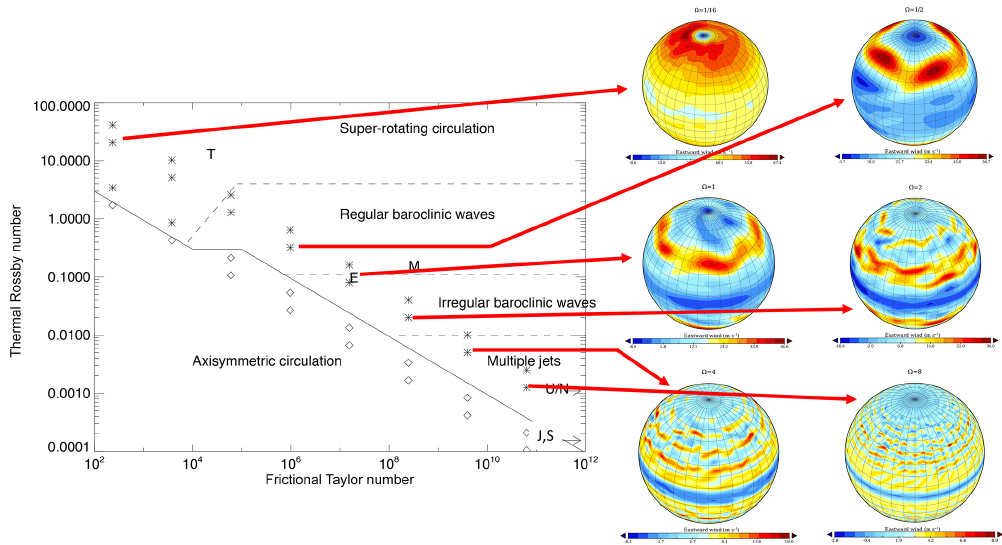
Figure 9. Regime diagram showing the various circulation regimes obtained in a simplified atmospheric general circulation model (Wang et al., 2018) with respect to characteristic dimensionless parameters ( Ro T and T F ). Stars refer to experiments in which wavy flows are observed, whereas open diamonds indicate experiments in which axisymmetric flows were found. The approximate locations in parameter space of some solar-system planets (Earth, Mars, Titan, Jupiter, Saturn, Uranus and Neptune) are labelled by their initial letters. The solid line delineates the boundary between axisymmetric circulations and circulations with wavy/turbulent flows. The dashed lines indicate the boundaries between different circulation regimes within the wavy/turbulent region. Some example snapshots of typical circulation patterns, visualised by shading of the zonal wind speed at the 200hPa level, are indicated by the arrows.